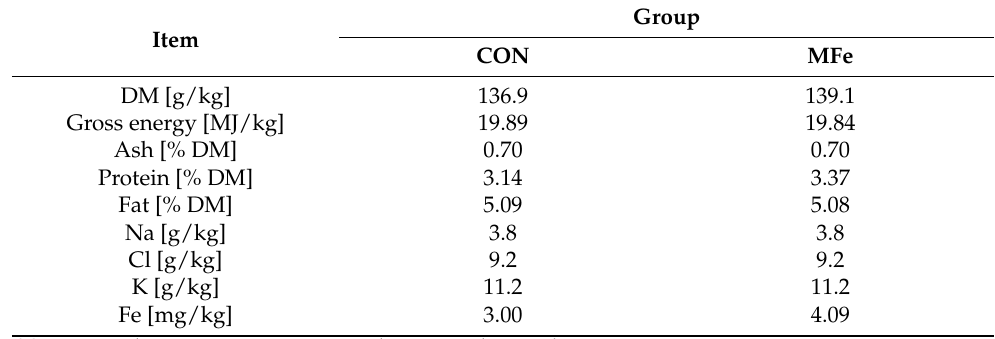
Table 1. The nutritional value of doses for individual experimental groups in DM.